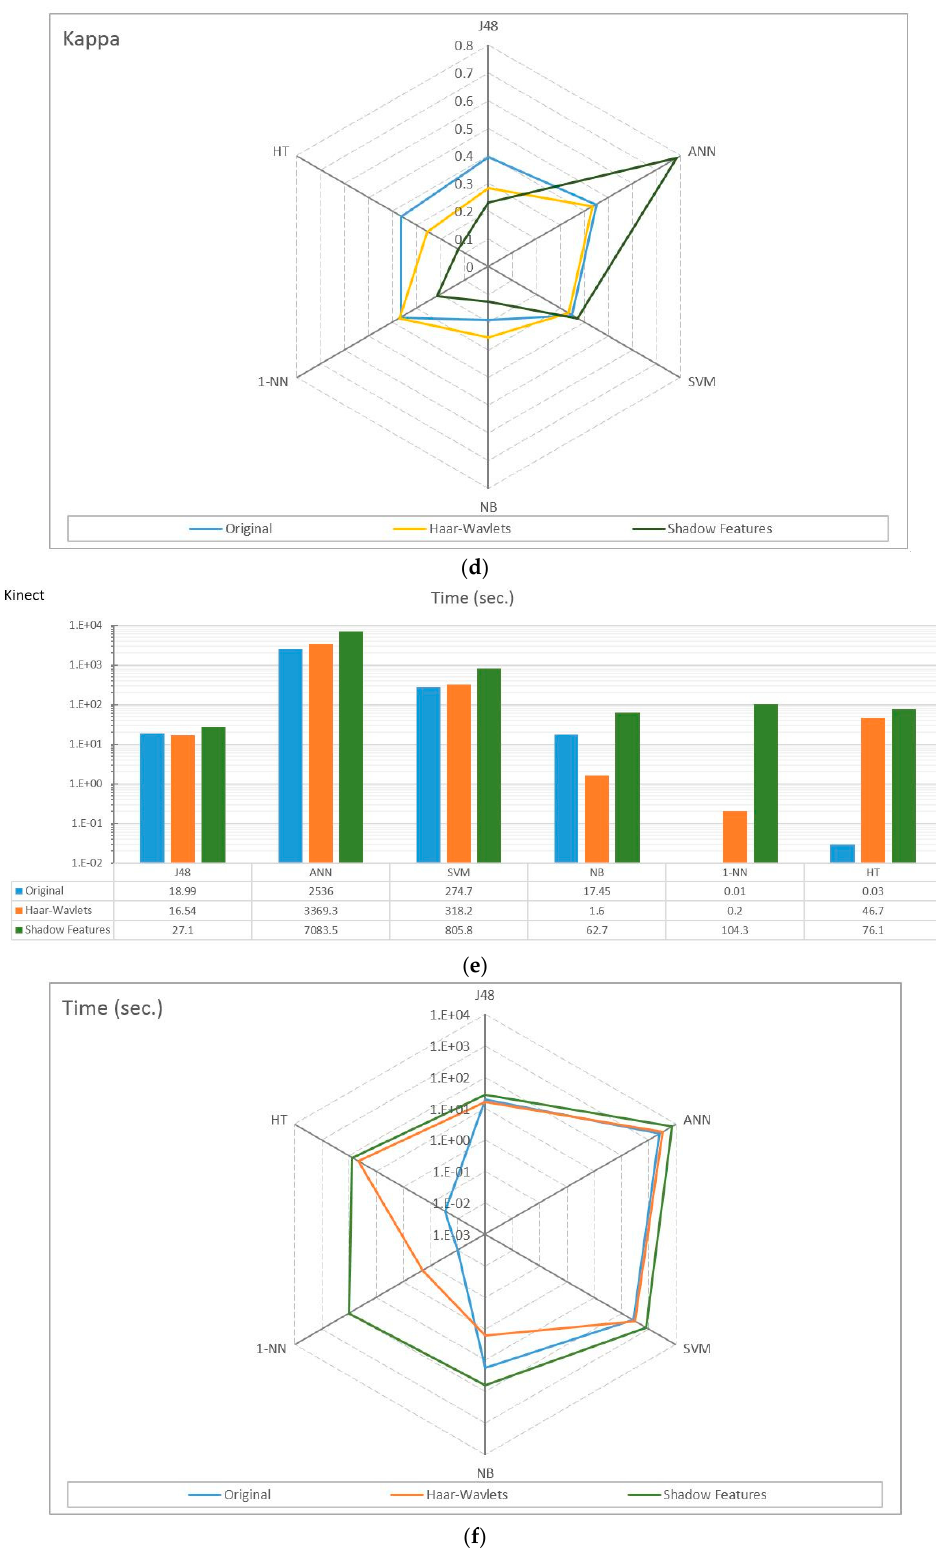
Figure 11. Major performance indicators of classifiers in Kinect data with different pre-processing strategies based on ( a , b ) F-measure of accelerator; ( c , d ) Kappa values of accelerator, and ( e , f ) Time (sec) in Log